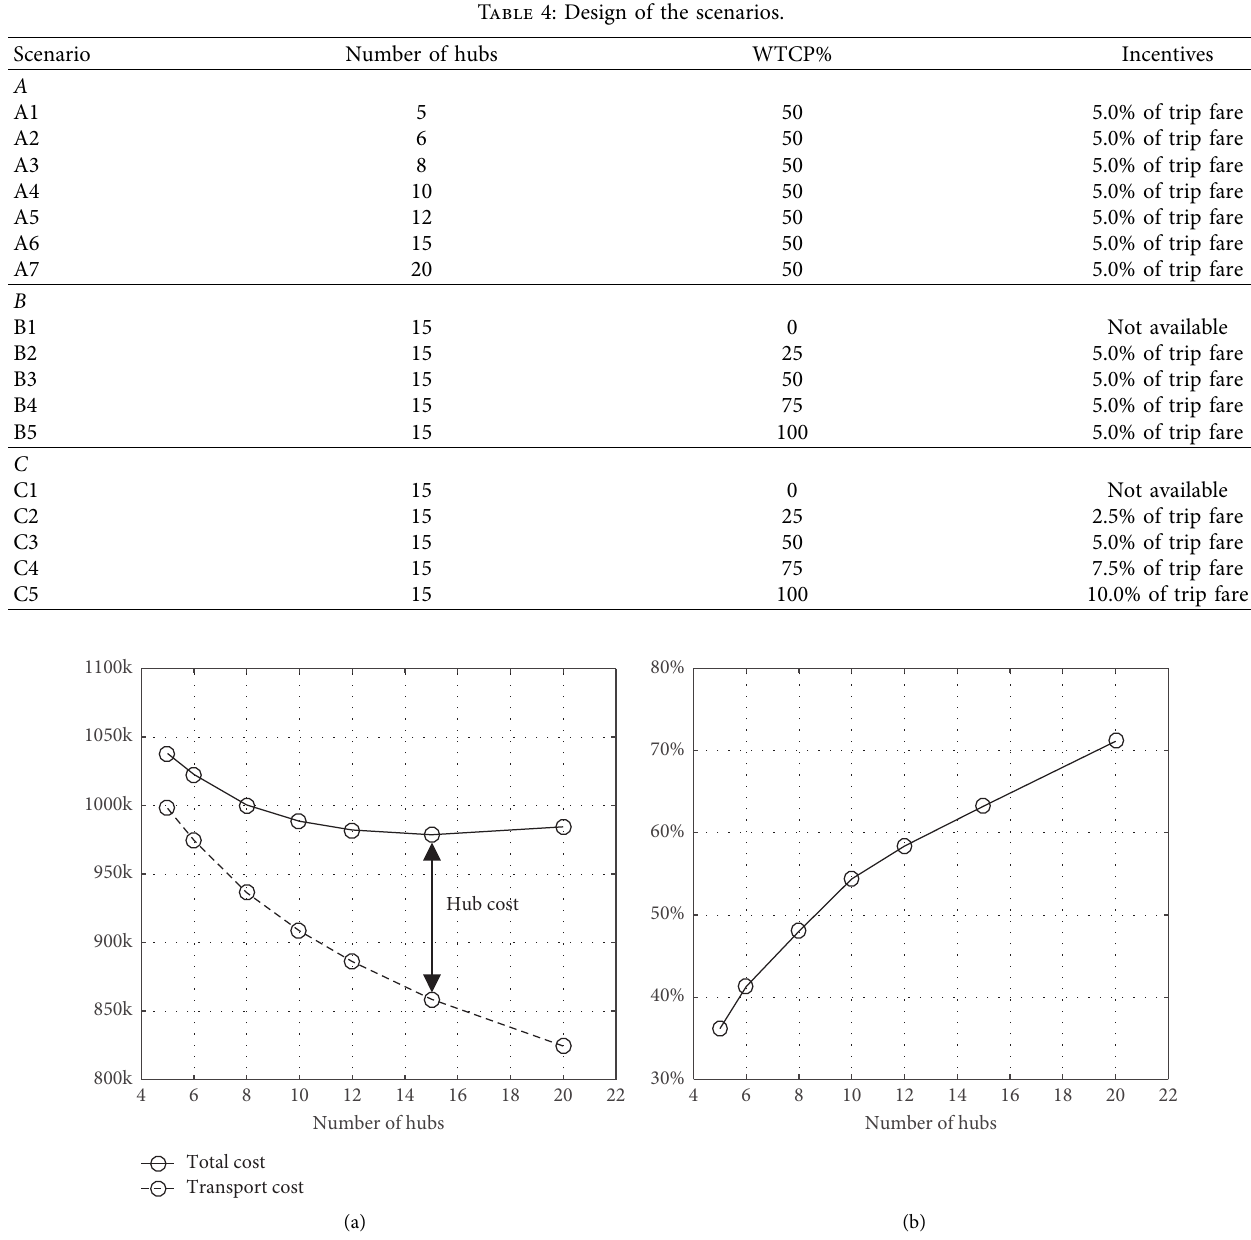
Figure 5: System cost (a) and proportion of packages transported by taxi on spoke links (b) by number of hubs.